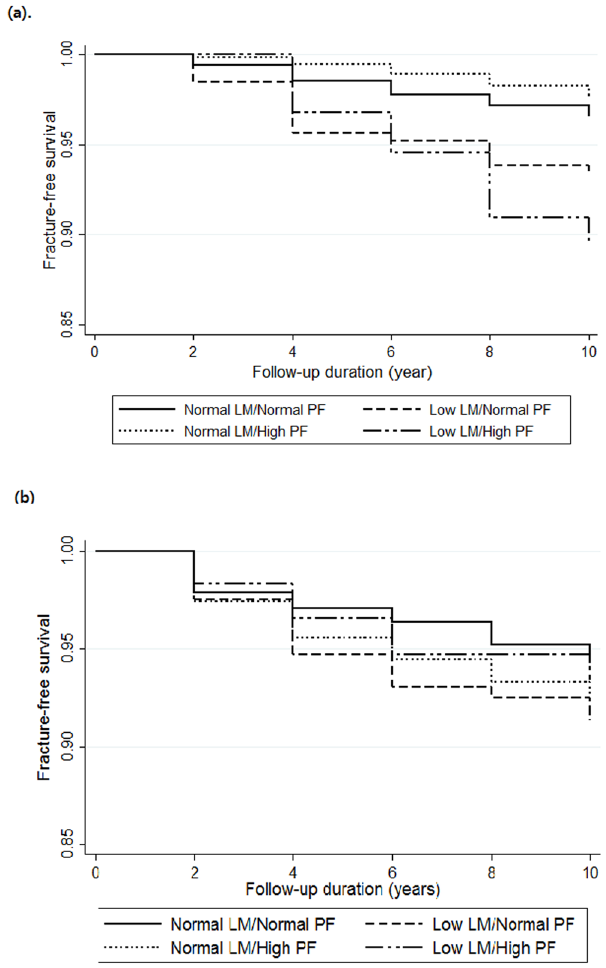
Figure 1. Event-free survival curve for fragility fracture according to body composition in ( a ) men and ( b ) women.